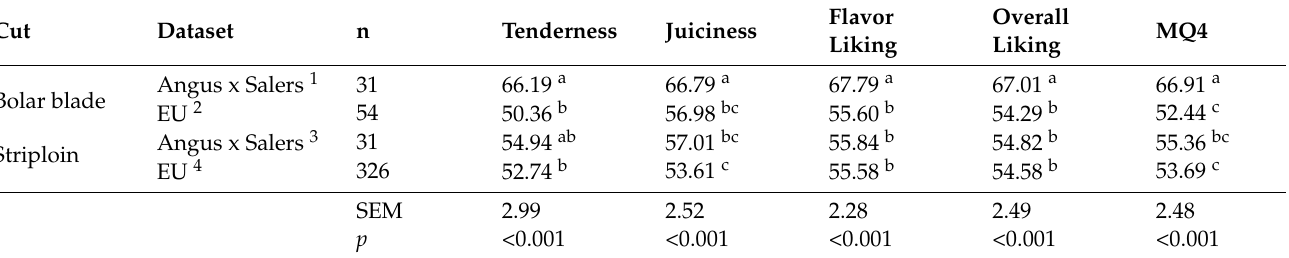
Table 6. Consumer scores on meat eating quality traits based on the present database versus the European database